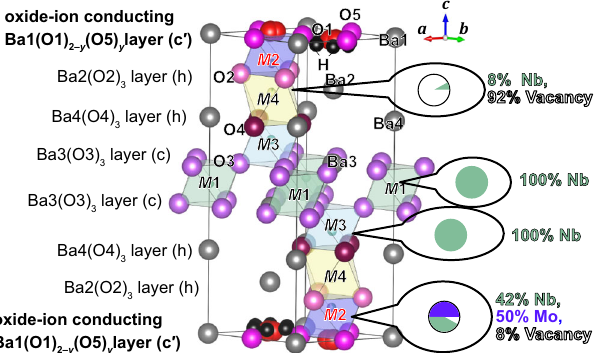
Fig. 6 | Crystal structure of Ba 7 Nb 4 MoO 19.849 (OH) 0.302 . Re fi ned crystal structure